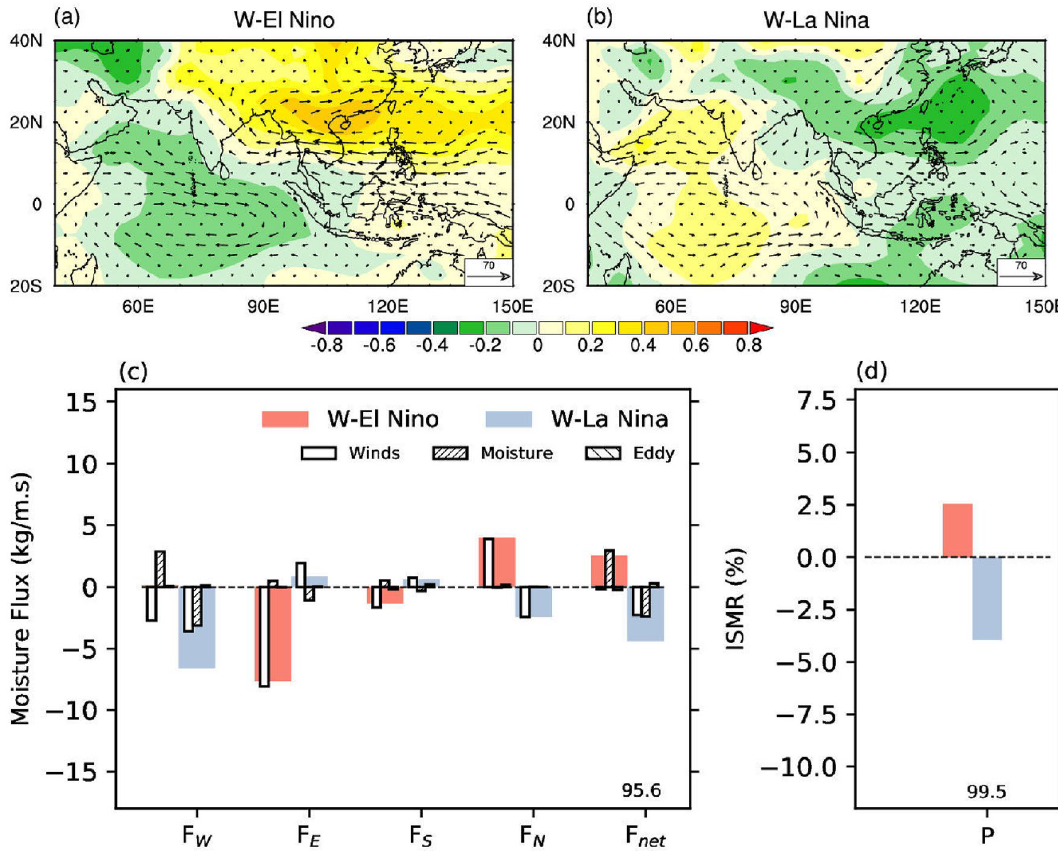
Figure 6. The teleconnection to preceding winter El Nino Southern Oscillation (W-ENSO). Composite change in the anomalous surface pressure (hPa) and vertically integrated moisture flux vector ( kgm − 1 s − 1 ) during ( a ) winter El Nino (W-El Nino) and ( b ) winter La Nina (W-La Nina). ( c ) Shows the vertically integrated moisture flux anomalies and its decomposition along the four boundaries (west ( F W ), east ( F E ), south ( F S ), and north ( F N )) and net moisture convergence ( F net ) over region marked as ABCD in Fig. 1a, for W-El Nino (red) and W-La Nina (blue) years. The contribution to total moisture flux (solid fill) and its components: due to winds ¯(cid:3) Vq (cid:4) (cid:5) ), and eddy flux ( (cid:2)(cid:3) V (cid:4) q (cid:4) (cid:5) ). ( d ) The corresponding change in the Indian summer monsoon ( (cid:2)(cid:3) V (cid:4) ¯ q (cid:5) ), moisture ( (cid:2) rainfall (ISMR) during W-El Nino and W-La Nina. The number along F net and P represents the significance level at which the hypothesis that means are the same for W-ENSO years is rejected. We regress out the impact of ENSO from all variables shown in this plot. This figure was created using NCL version 6.4.0 (https:// www. ncl. ucar.